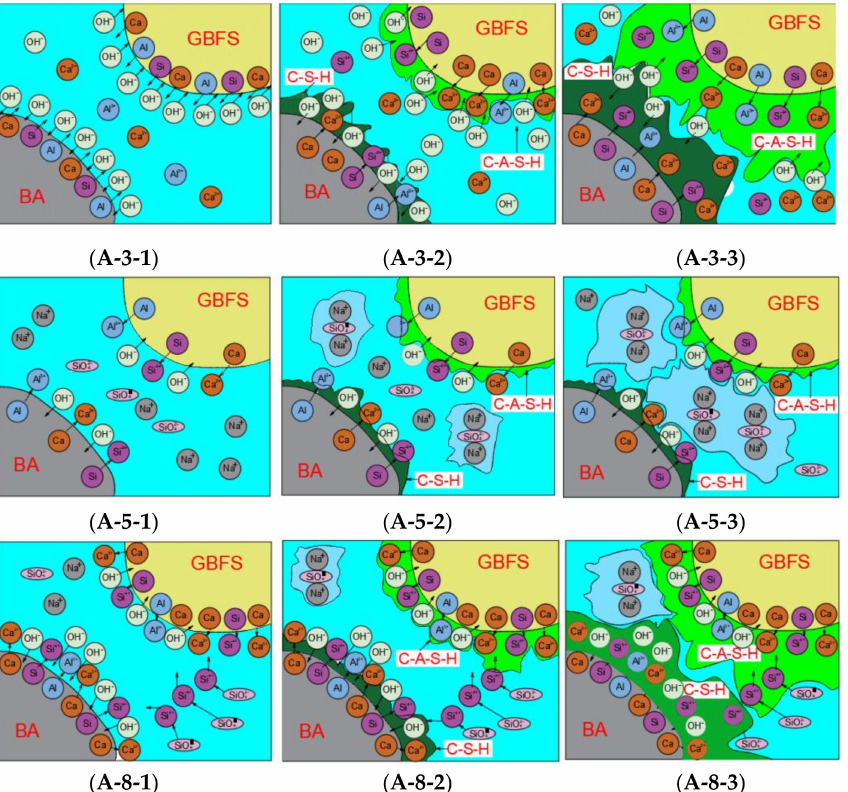
Figure 5. Polymerization mechanism of BA alkali-activated samples ( A-3 , A-5 , A-8 ); ( A-3 ) NaOH was used as sole initiator; ( A-5 ) liquid sodium silicate was used as sole initiator; ( A-8 ) both liquid sodium silicate and NaOH were used as